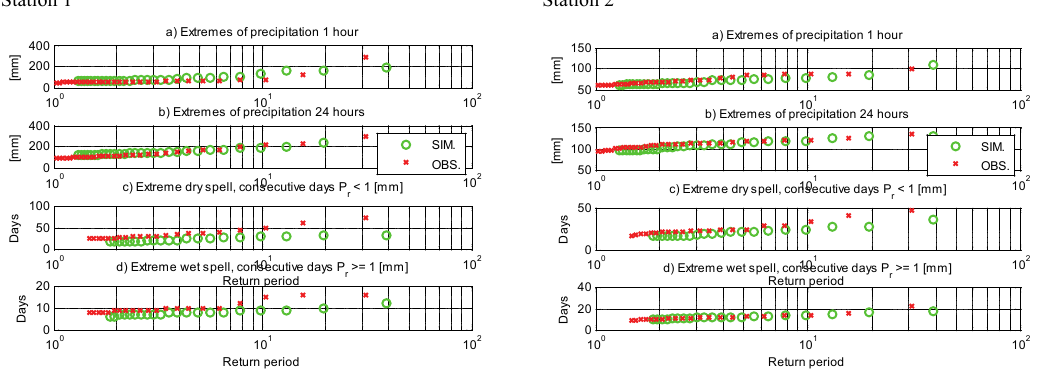
Fig. 2 A comparison between the observed and simulated values of extreme precipitation at (a) 1-h and (b) 24-h aggregation periods; (c) extremes of dry and (d) wet spell